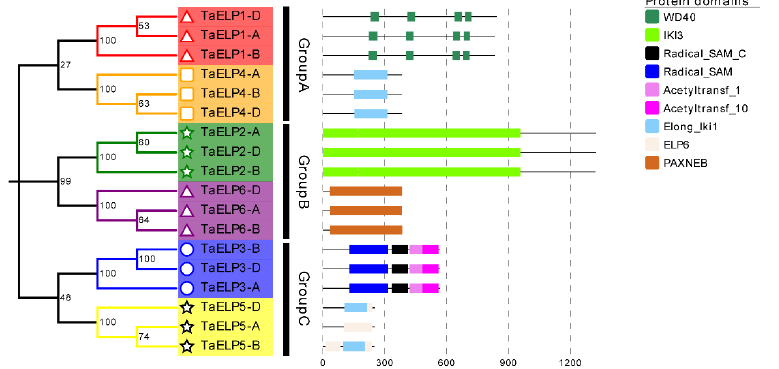
Figure 5. The conserved domain of TaELP members was identified from Pfam and SMART databases and presented using Evolview.